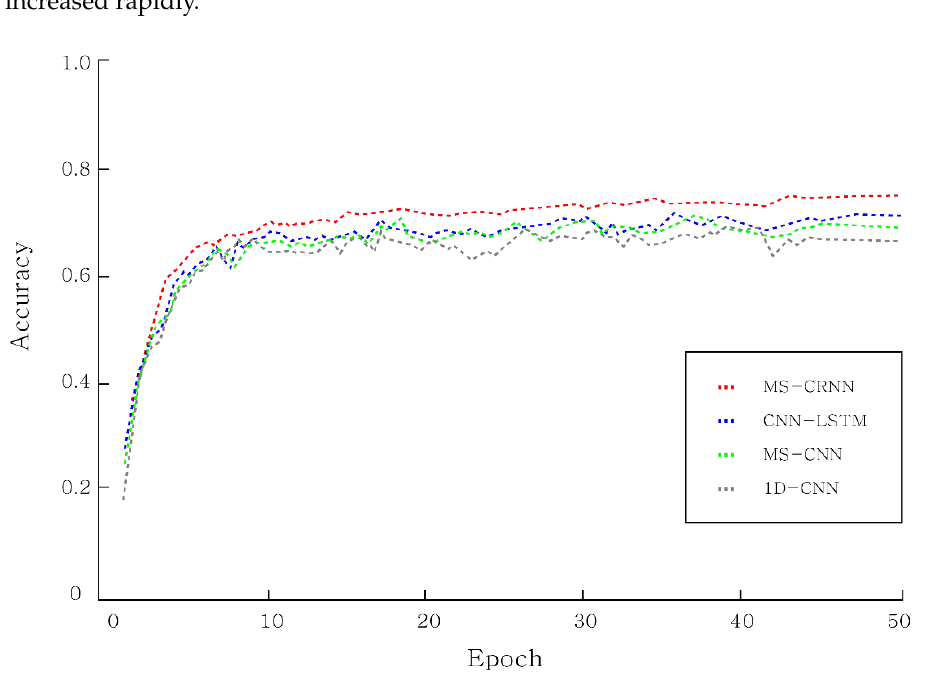
Figure 9. Plot of the experimental results obtained for the noisy state.